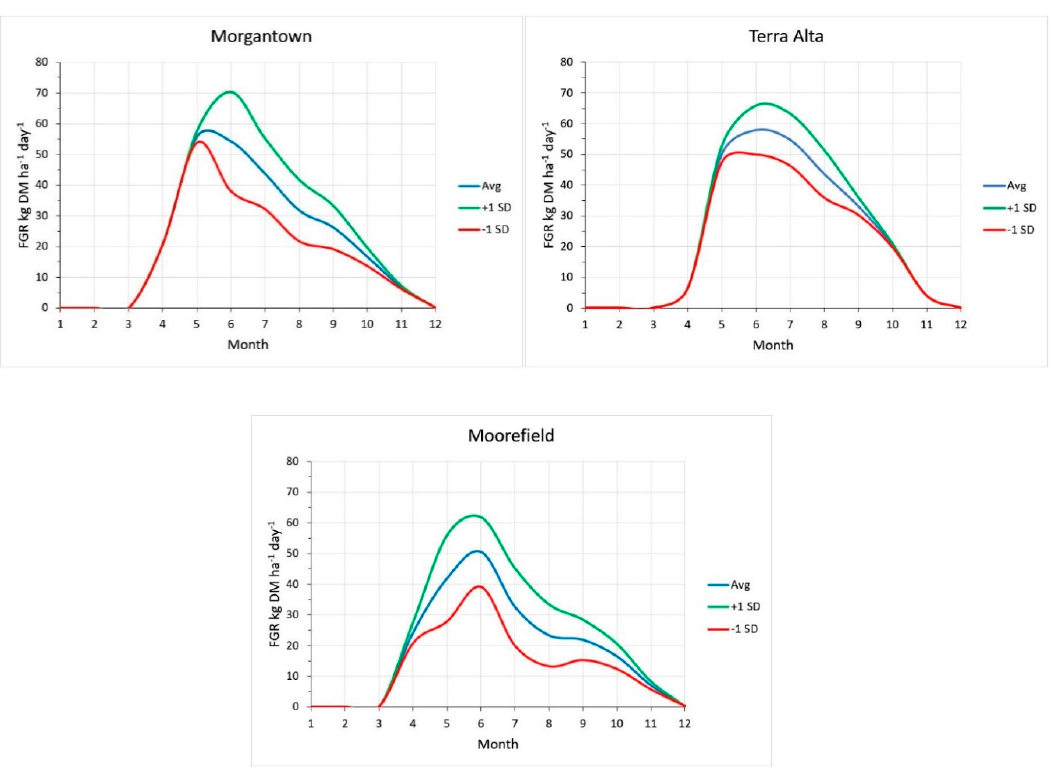
Figure 8. Average and variability ( ± 1 SD) of pasture growth at three sites in the Allegheny Plateau and Mountains, and Northern Appalachian Ridges and Valleys.